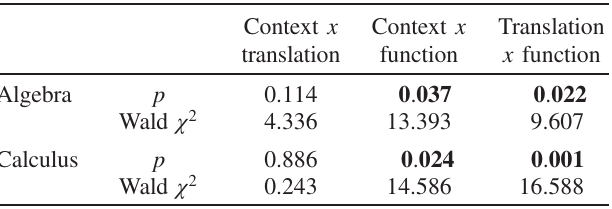
TABLE V. p values and Wald χ 2 for the interaction effects between the item variables on the accuracy of student answers. Significant effects are given in